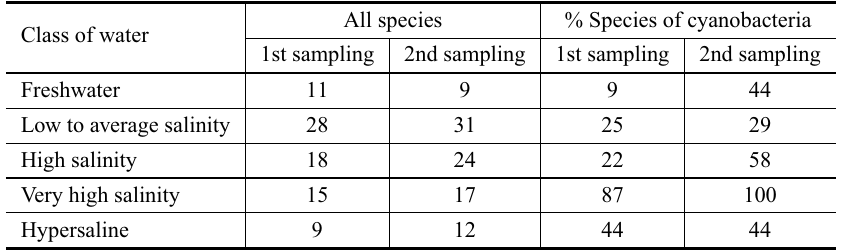
Species of phytoplankton observed in the lake samples from the Barranco Alto farm and the relative percentage of cyanobacteria. The first sample collection was done in July 2008 and the second in October